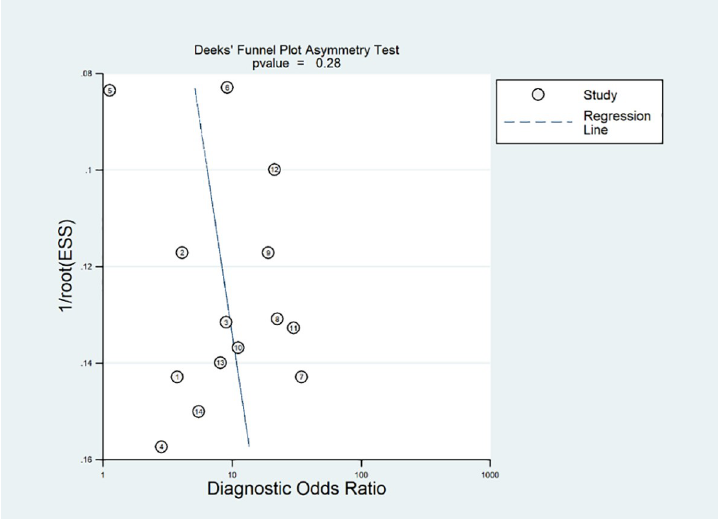
Fig 3. Deeks’ funnel plot asymmetry test. Non-significant slope indicates that no significant bias was found. ESS; Effective sample size.